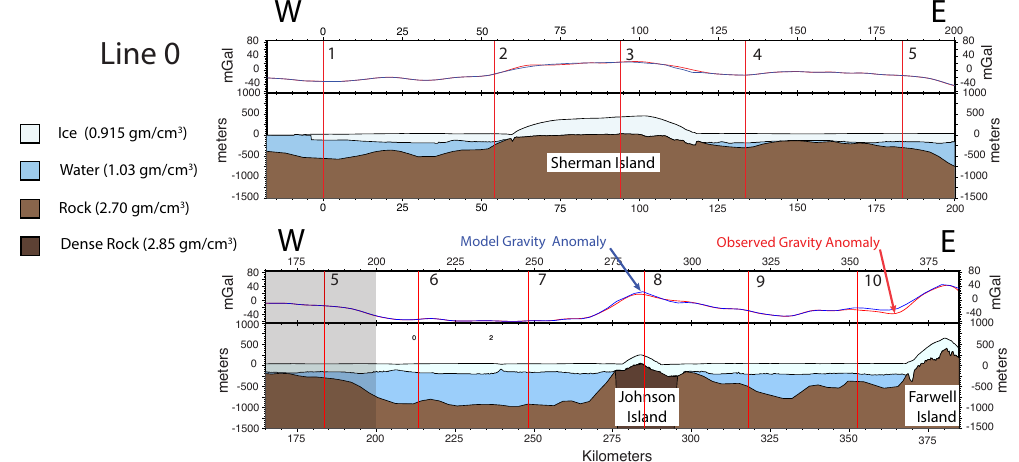
Fig. 3a. Airborne geophysics line 0 along the axis of the Abbot Ice Shelf (Fig. 2) broken into two segments with 35km of overlap (shaded area in the lower panel). Vertical red lines show where line 0 intersects north–south lines 1–10 (Fig. 3b). For each segment, the upper panel shows the observed free-air gravity in red and the anomaly predicted by the inversion in blue. Lower panels show the observed upper and lower ice surfaces from laser altimeter and radar measurements, respectively, and the upper surface of the solid Earth. Where ice is grounded, the Earth’s surface is determined from radar measurements. Where ice is floating, the bathymetry is determined from inversion of gravity anomalies.